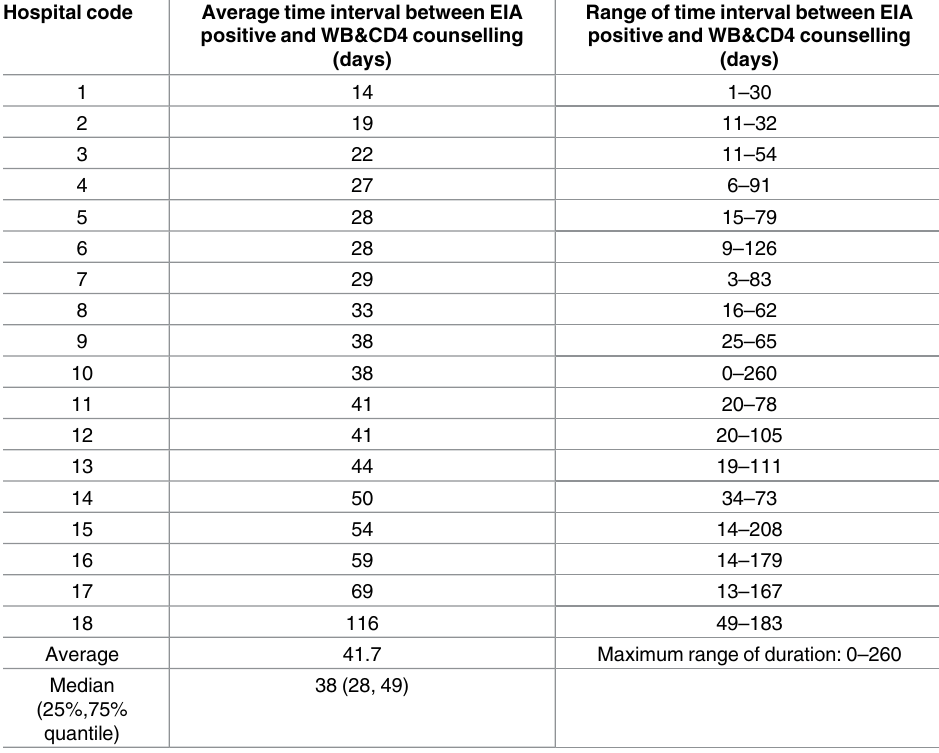
Table 2. Averagetime interval from initial EIA HIV screening to confirmatory counselling in 18 county hospitals in Guangxi,